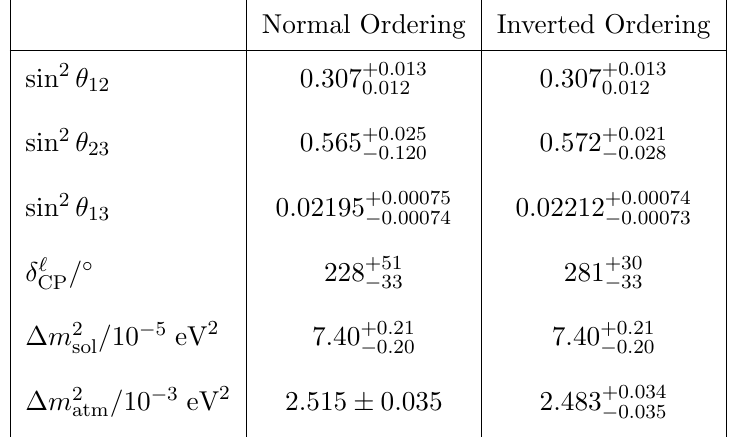
Table 1 . Three-(cid:13)avour oscillation parameters from the global (cid:12)t in ref. [67]. The second and third columns refer to the NO and IO, respectively. The notation chosen is (cid:1) m 2 (cid:1) m 2 (cid:17) m 2 (cid:0) m 2 for NO and (cid:1) m 2 atm (cid:23) 3 (cid:23) 1 the 1 (cid:27)